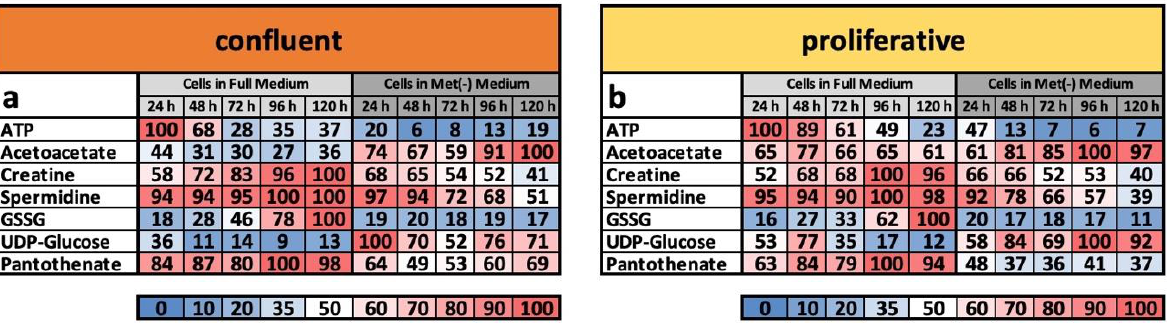
Figure 4. ( a , b ) Metabolic footprints of the cell line L929. The metabolism of the murine cell line L929 was analysed in full medium and MetR under both confluent ( a ) and proliferative conditions ( b ) over a period of 5 days. For each day of the experiment, the preparation was performed in triplicate. After 24, 48, 72, 96 and 120 h, the cell lysates (intracellular) were analysed by LC/MS. The results were reproduced in four independent experiments and finally summarised. This figure shows the results of the intracellular metabolites used to define the metabolic footprint for LEM. For the cell pellets, the highest measured value in each test series was defined as 100%.